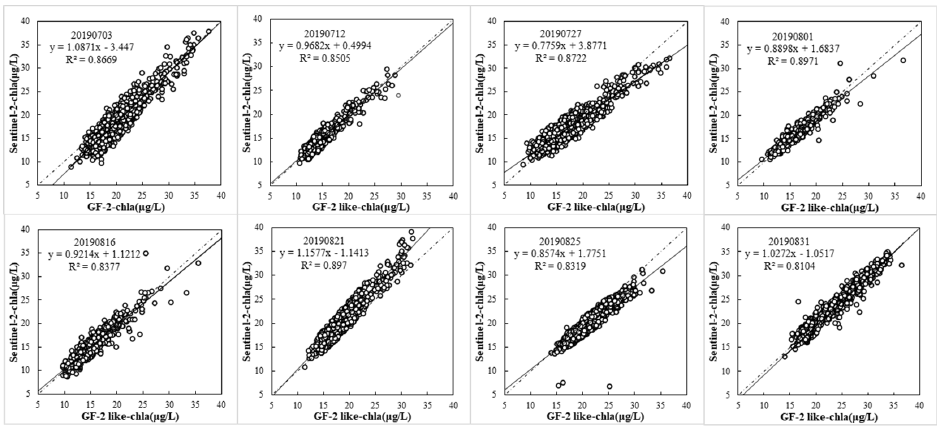
Figure 4. Comparison of four phase Chl– a inversion results based on GF2-like images and Sentinel-2 images [53].